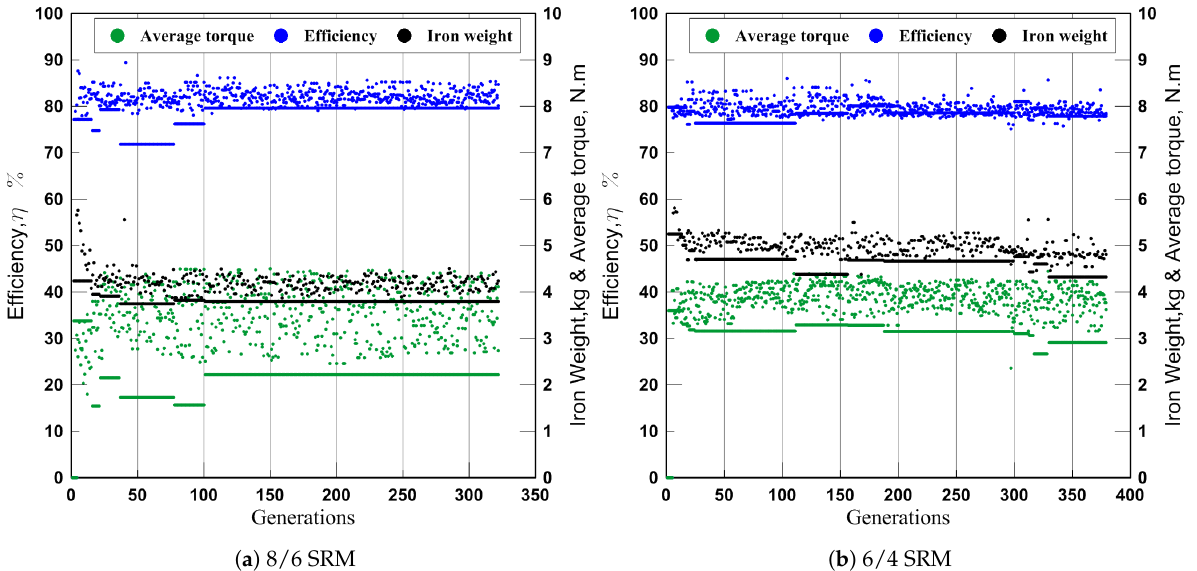
Figure 7. Objective functions progress with number of